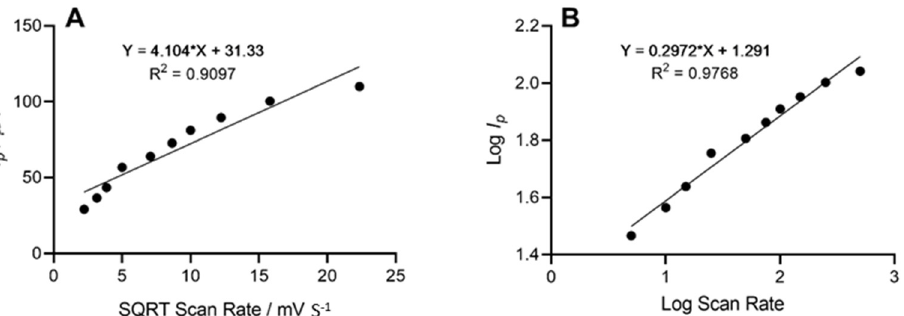
Figure 5. ( A ) Voltammetric anodic peak height of cadaverine expressed as a function of the square root of the scan rate. The line equation shows a linear relationship between peak height and square root scan rate with an R 2 value of 0.9097. ( B ) Log peak current vs. log scan rate demonstrated a linear trend and a slope of 0.29 representing a diffusional controlled electrochemical process.